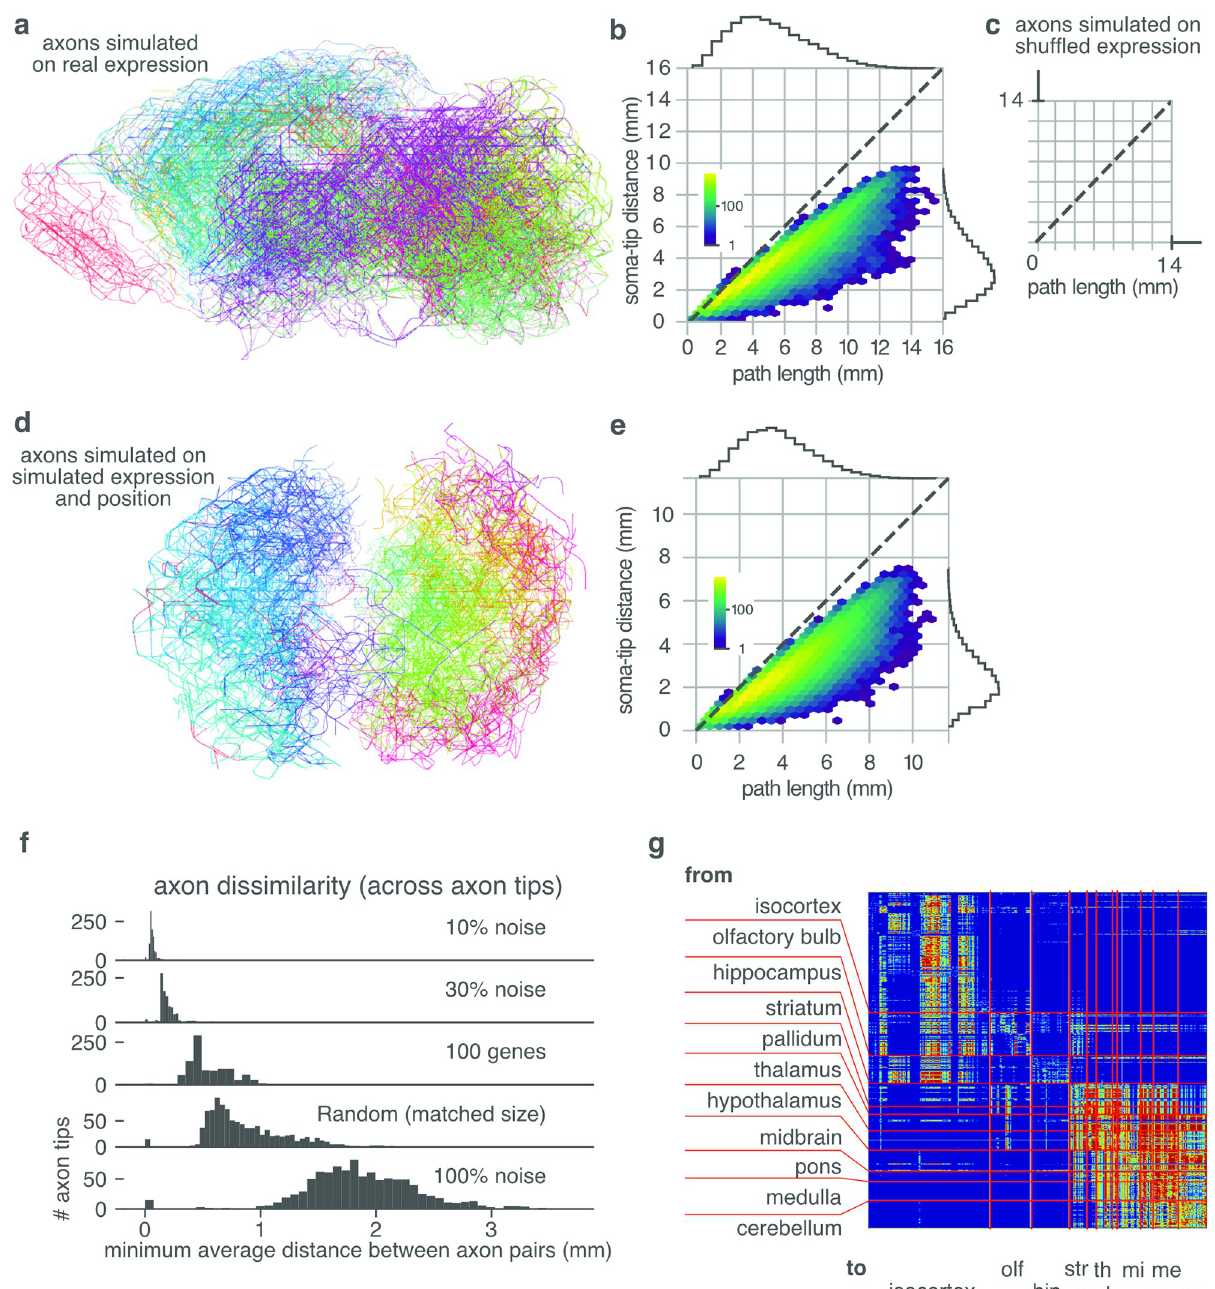
Fig 9. Simulated axons use familial guidance to navigate through the voxels of the ABI developing mouse brain gene expression atlas. A Arborizations of 50 example axons, show in a sagittal projection of the ABI atlas hemisphere. Each arbor is the collection of all branches that an axon could potentially navigate using this gene expression space. Each axon is colored according to its source region. The colors correspond to those of Fig 5B. B Straight-line distance between the beginning of a branch (soma) and end of that branch (top) versus the actual path length. Branches are points sorted in hexagonal 2D bins, whose color intensity indicates the number of branches in that bin. C Same as B , but expression values are shuffled before the hierarchical decomposition and axon guidance algorithm are applied. In this control case guidance fails completely, and no axons cannot guide outside their original voxel. D Arborizations of 50 example axons using the same algorithm as in A , but on tissue grown in simulation (as in Fig 8). E As B , but for the simulated tissue of D . F The dissimilarity, measured as the average minimum distance between axon tips, between simulated axons on experimental expression (as in A ). Axons begin from the same voxel, but are under varying levels (10%–100%) of expression noise; or guide using only a subset of 100 genes selected randomly (i.e., the same 100 genes are used for all simulated axons). Because the navigation algorithm is deterministic the 0% noise case produces identical neurons. The familial guidance dissimilarity is compared against a random walk axon of the same path length. G